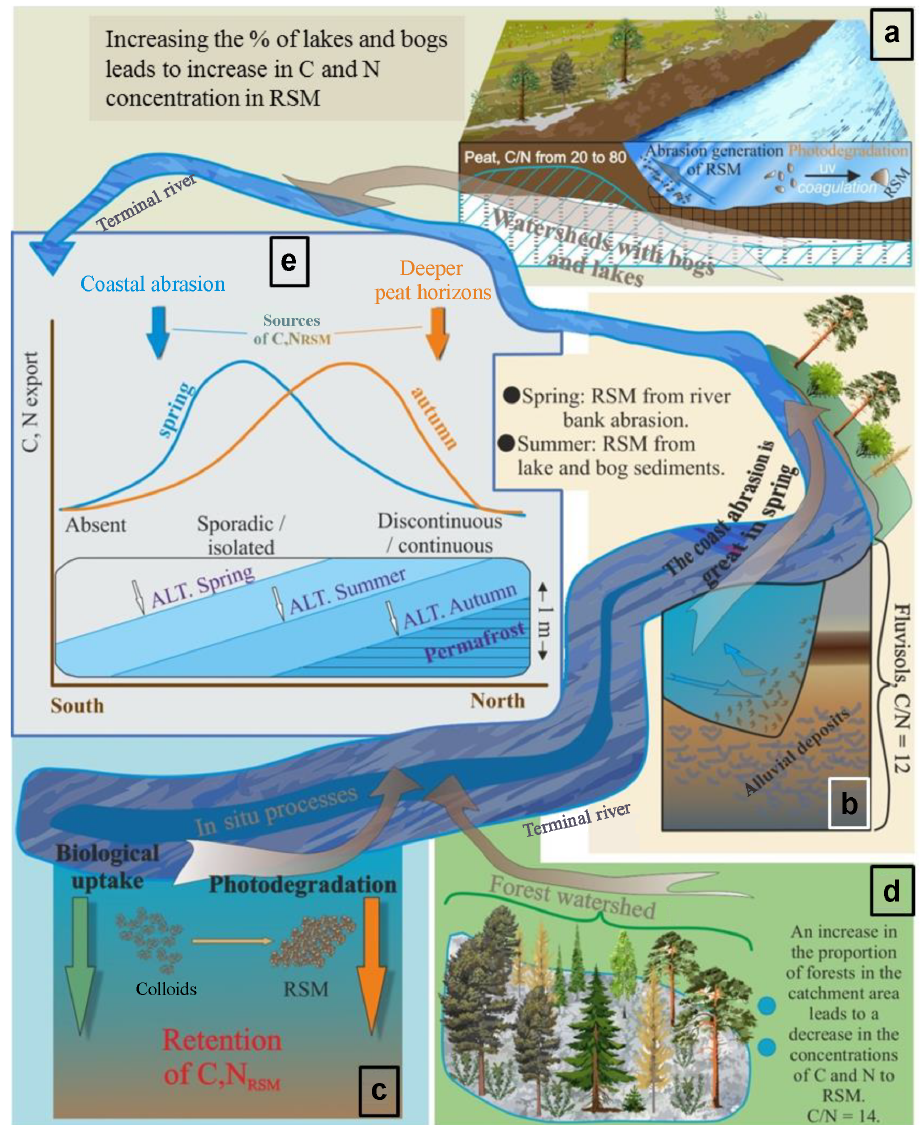
Figure 7. A cartoon of spatial and temporal partitioning of particulate nutrients in WSL rivers across the permafrost gradient. The panels (a) , (b) , (c) and (d) represent the main sources ( a : lakes and bogs in summer, and b : alluvial deposits in spring) and sinks ( c : photodegradation and bio-degradation, and d : uptake by taiga forest) of particulate nutrients in WSL rivers. The panel (e) depicts the spatial gradient of C and N in RSM occurring in spring (blue line) and autumn (red line). A non-steady-state physical erosion of peat soils in WSL provides the maximum of particulate nutrients within the zone of most “fragile” actively thawing permafrost. The maximal thickness of the active layer progressively moves to the north during the active season, thus leading to the maximal removal of particulate C, N and P at the thawing